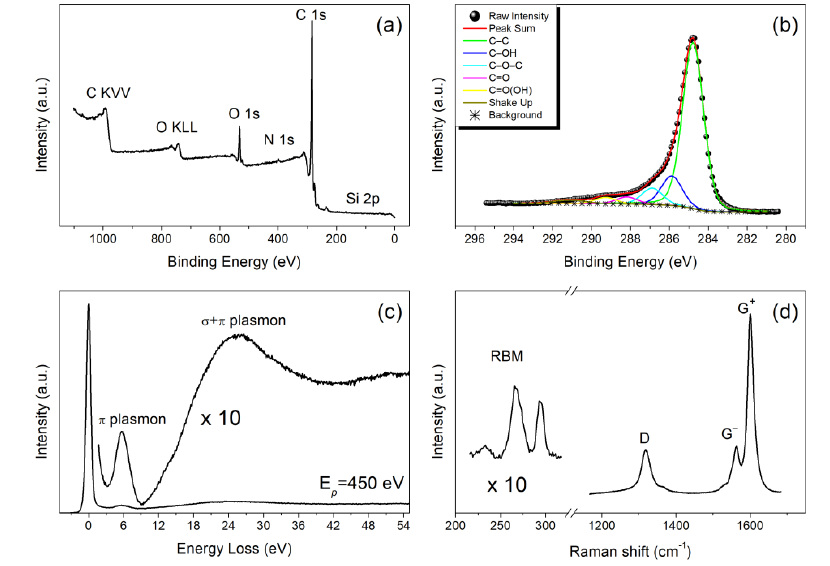
Table 1. RBM frequency (ω) obtained from the Raman spectrum and the evaluated diameter ( d ), chiral vector index ( n,m ), and nature of the SWCNTs.